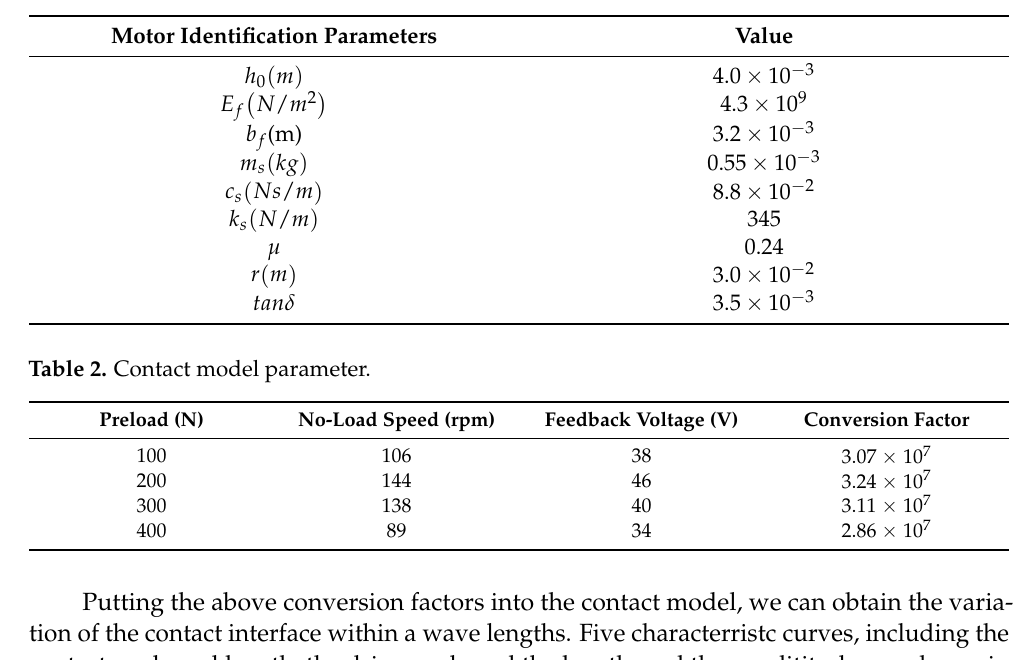
Table 1. Motor identification parameters.